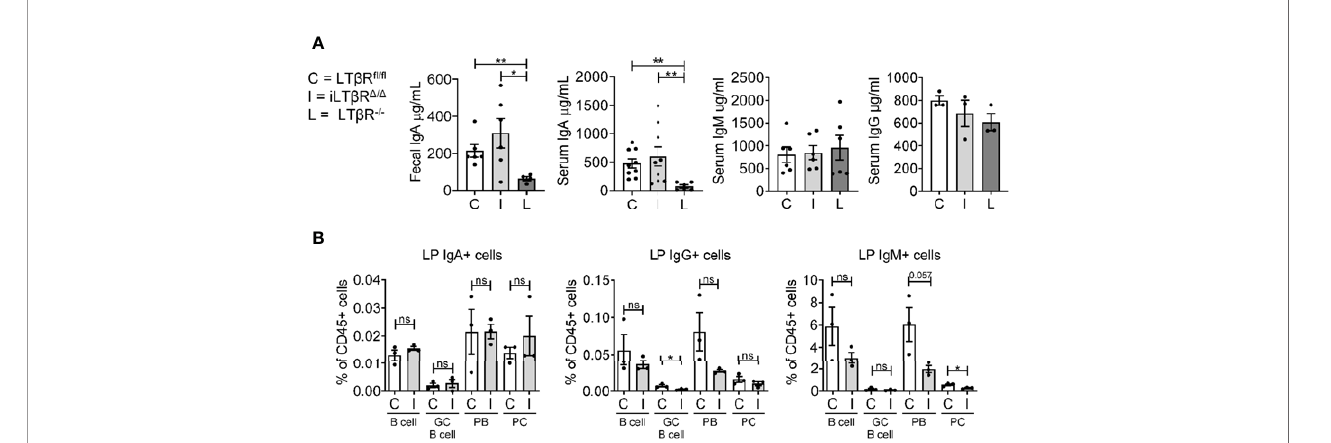
FIGURE 5 | LT b R signaling in adulthood is dispensable for the IgA production. iLT b R D / D (I) mice were analyzed 4 months after TAM administration. LT b R fl / fl (C) and LT b R -/- (L) mice were used as controls. (A) Total IgA, IgM and IgG levels measured by ELISA (n=3-9 mice per group). Signi fi cance determined by one-way ANOVA with Dunn ’ s correction. Collective data from two separate experiments is shown. (B) Flow cytometry analysis of immunoglobulin producing cells from colon LP: CD138 - CD19 + GL7 - B cells, CD138 - CD19 + GL-7 + germinal center (GC) B cells, CD138 + CD19 + plasmablasts (PB), CD138 + CD19 - plasma cells (PC). Graphs depict % of cells in CD45 + gate. N=3 for all groups. Signi fi cance was determined by unpaired t-test. Data shown is from one representative experiment out of two. Gating strategy shown in Figure S5 . Data shown are means ± SEM. Not signi fi cant (ns, p > 0.05), *p < 0.05, **p <